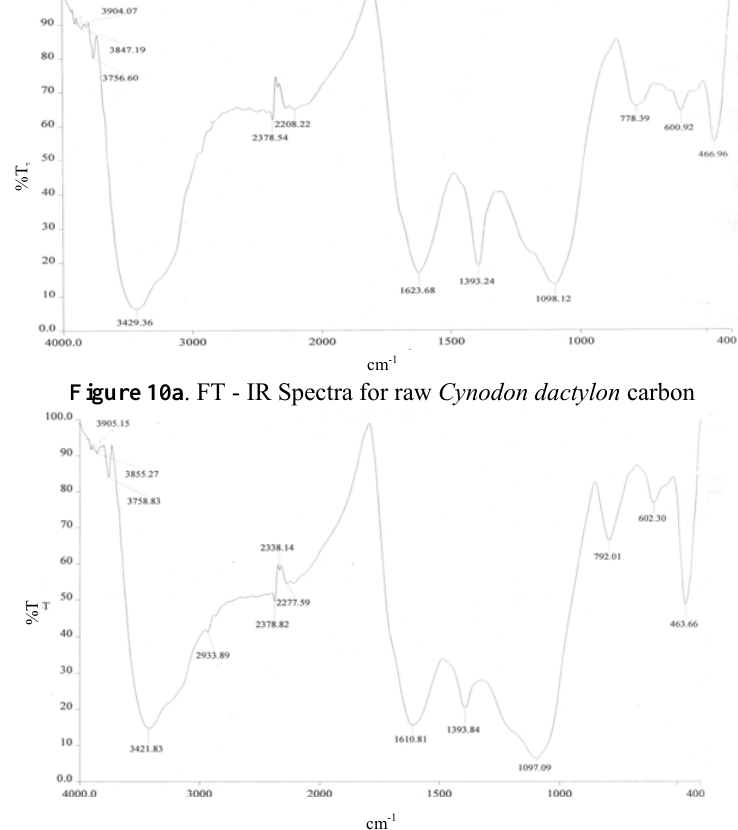
Figure 10b. FT - IR Spectra for the adsorption of copper ion onto